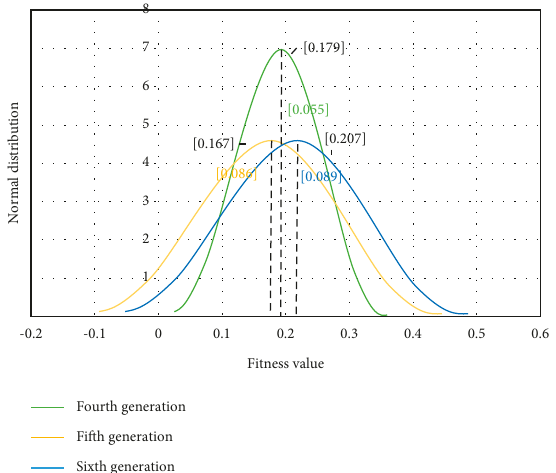
Figure 4: Diversity distribution curve of the “volume/projected area” values of the sixth-generation sample of test sequence 1